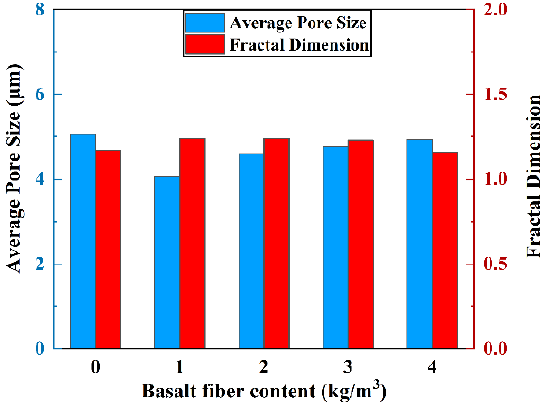
Figure 14. Pore microparameters.